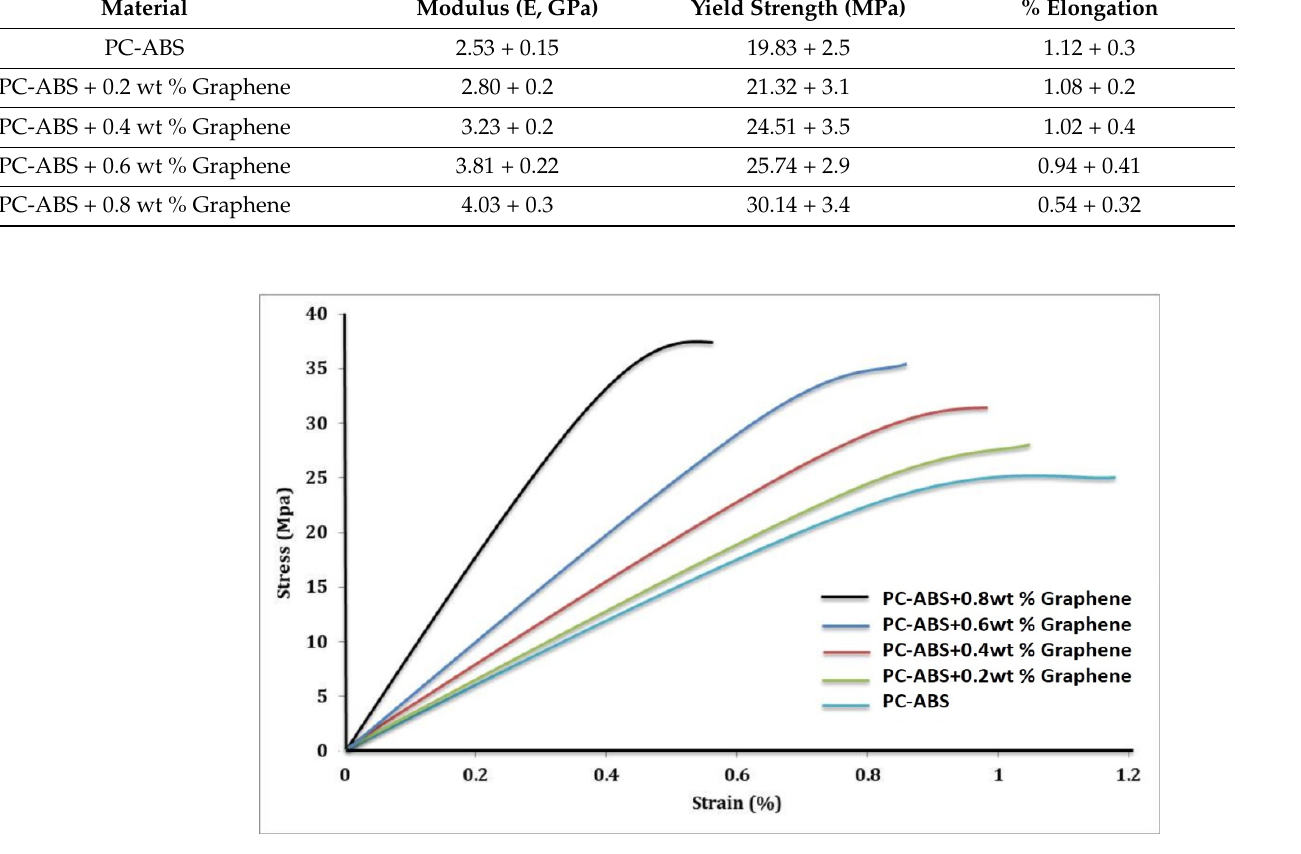
Figure 17. Stress–strain graph of PC-ABS and its